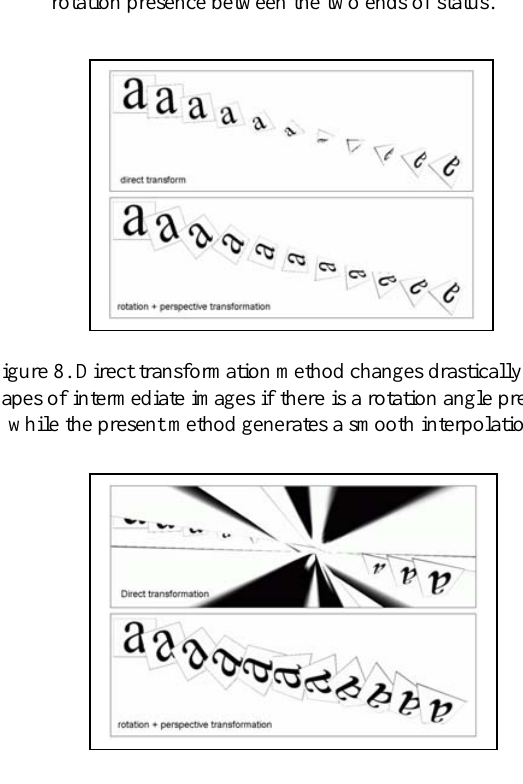
Figure 8. When the rotation is large, direct transformation method will flip intermediate images, meanwhile decomposing the transformation into rotational and perspective components will confine the transformation on the mosaic plane, therefore generates smooth